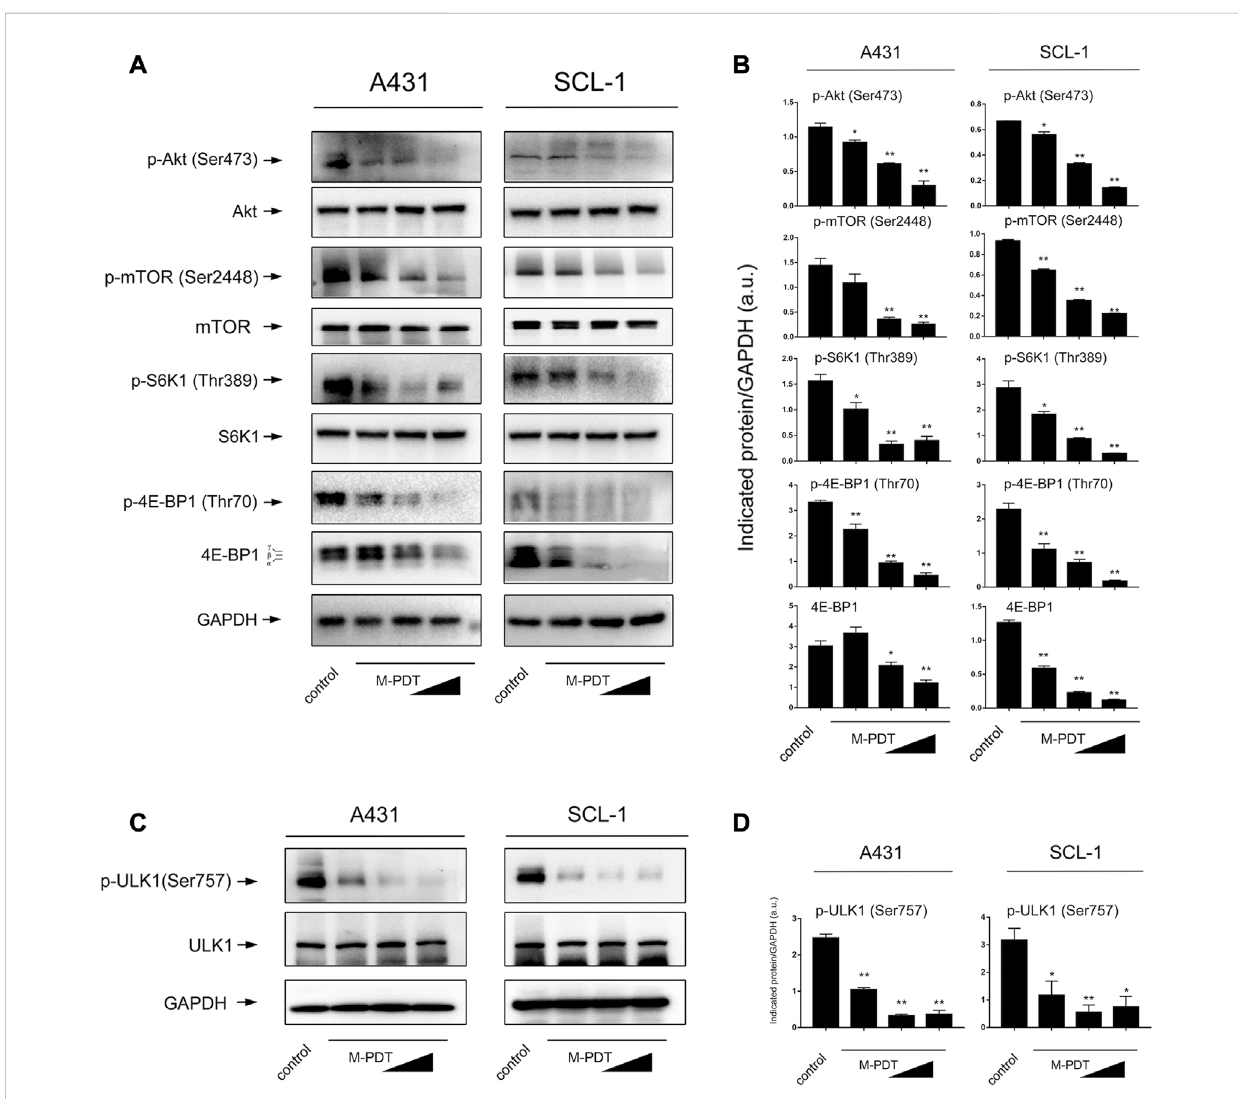
FIGURE 5 M-PDT inhibits Akt/mTOR signaling pathway in cSCC cells. (A, C) Western blot for indicated antibodies. GAPDH is a loading control. (B, D) The blots for p-Akt, p-mTOR, p-S6K1, p-4E-BP1,4E-BP1, p-ULK1 were semi-quanti fi ed. * p < 0.05, ** p < 0.01, difference vs. control group. n =